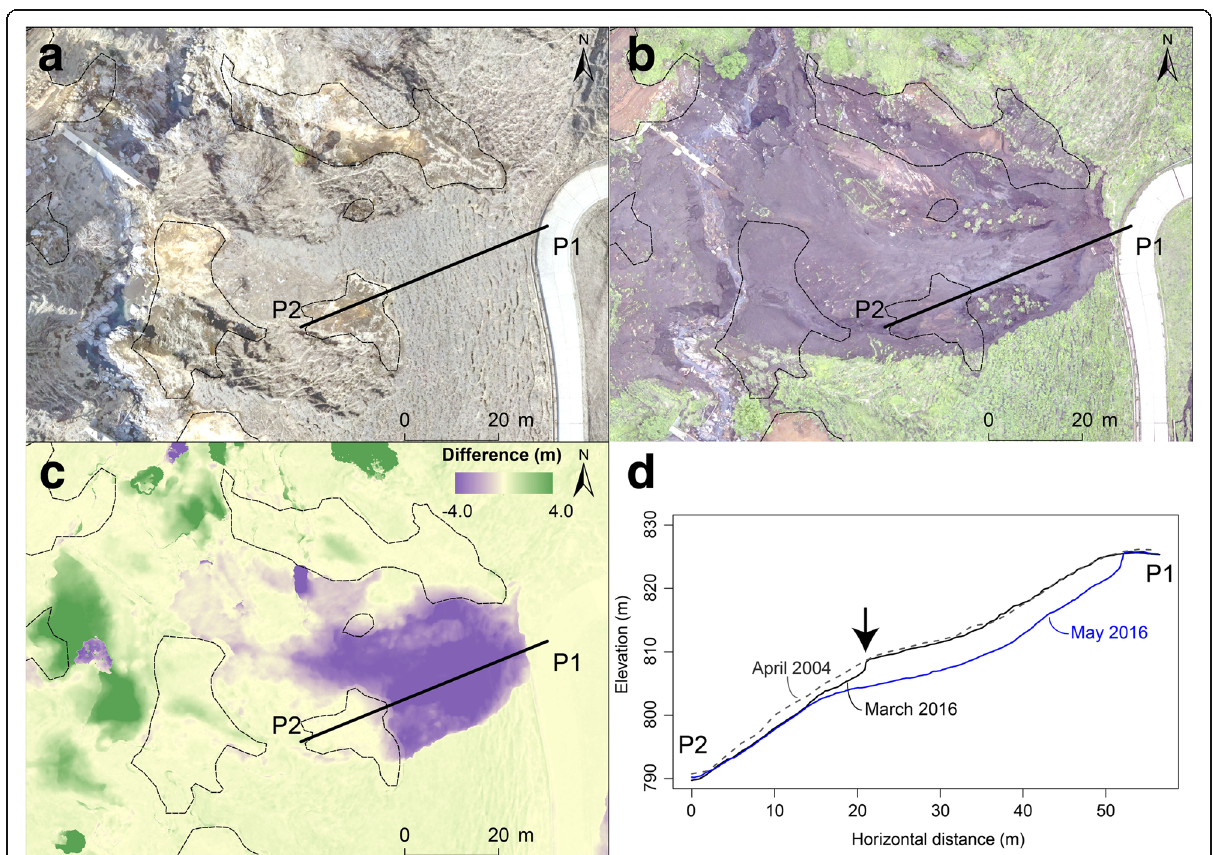
Fig. 4 Examples of landslides triggered by the heavy rainfalls of 2012 (black polygons) and the 2016 Kumamoto earthquake (shown in b ) on orthorectified images acquired in a March 2016 and b May 2016. c Difference of digital surface models (DSMs) between March and May 2016 (blue represents a decrease in DSM). d Profile of the slope on which the landslide was located in April 2004 (gray dashed line), March 2016 (black line), and May 2016 (blue line), shown by the black profile line (P1 – P2). The arrow in d shows the scarp of the rainfall-induced landslide in 2012. The slope profile in April 2004 was derived from lidar-based DSM with a spatial resolution of 2.0 m (Saito et al.